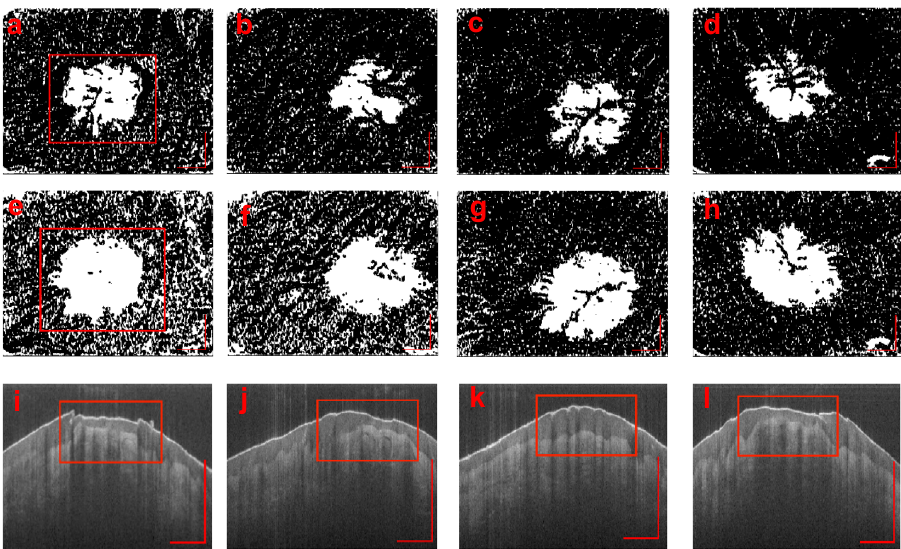
Figure 2. Progression at the superficial ( a - d ) and deep ( e – h ) slice-stacks, and the structural cross-sections ( i - l ) over the course of four imaging sessions P2L1. The axis in each image represents a 1 mm × 1 mm bar.